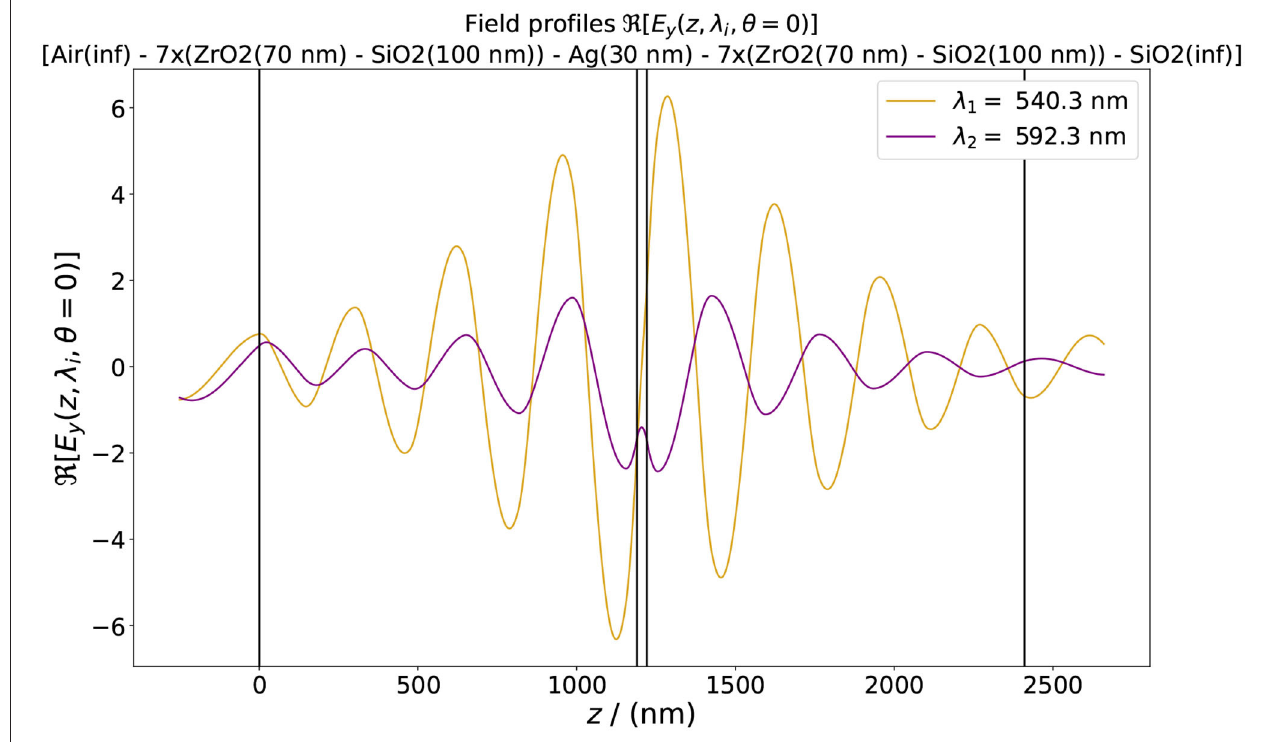
FIGURE 16 | Profiles of E y along the z -axis in the stack for vertical incidence of light. The vertical lines indicate the boundaries of the photonic crystals and the silver